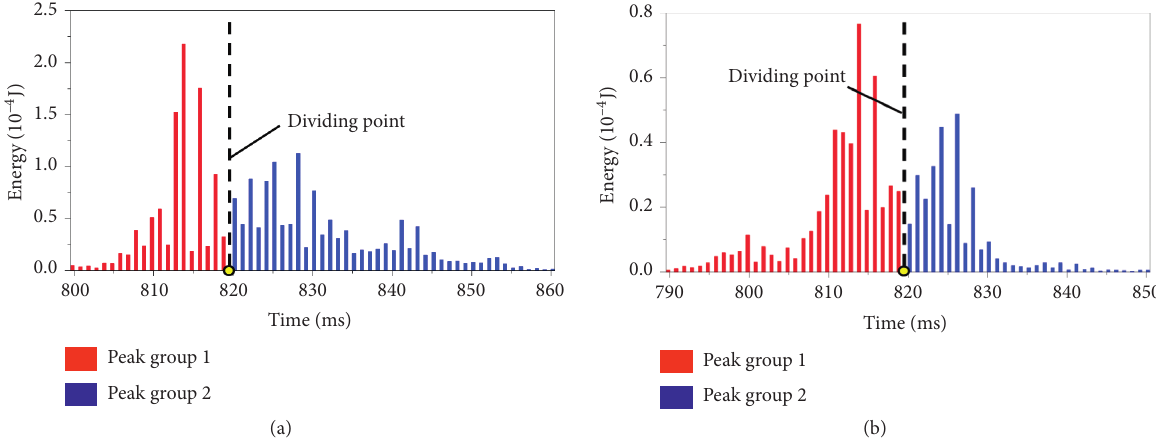
Figure 5: Time-energy density distribution histograms of the monitored vibration in vertical. (a) Monitoring point #2 (MS13). (b) Monitoring point #2